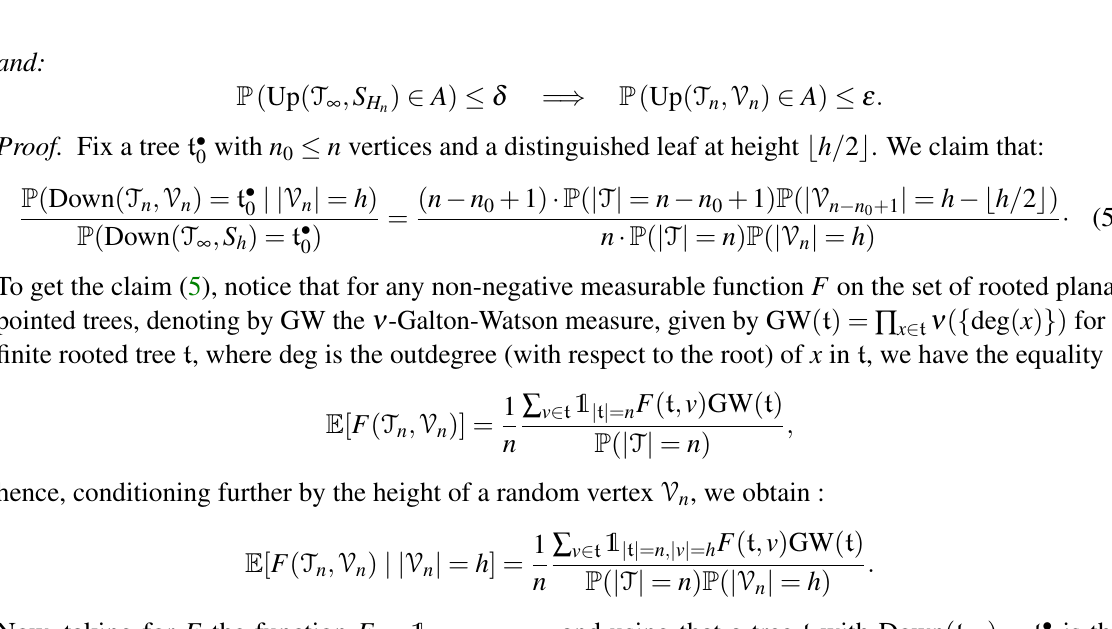
Figure 3: The different pieces cut out of a plane tree t with a distinguished vertex x